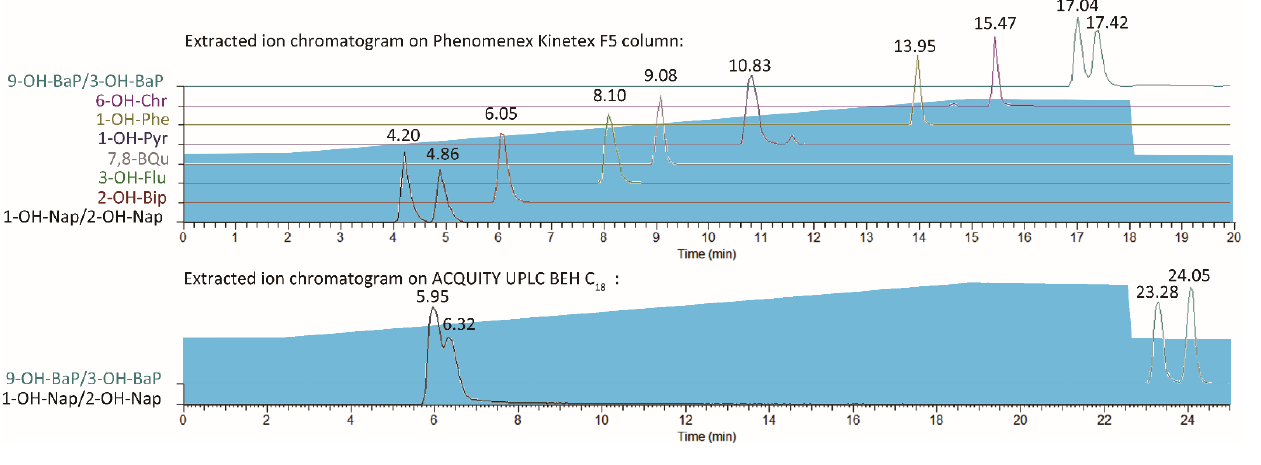
Figure 2. Extracted ion chromatograms on two columns.